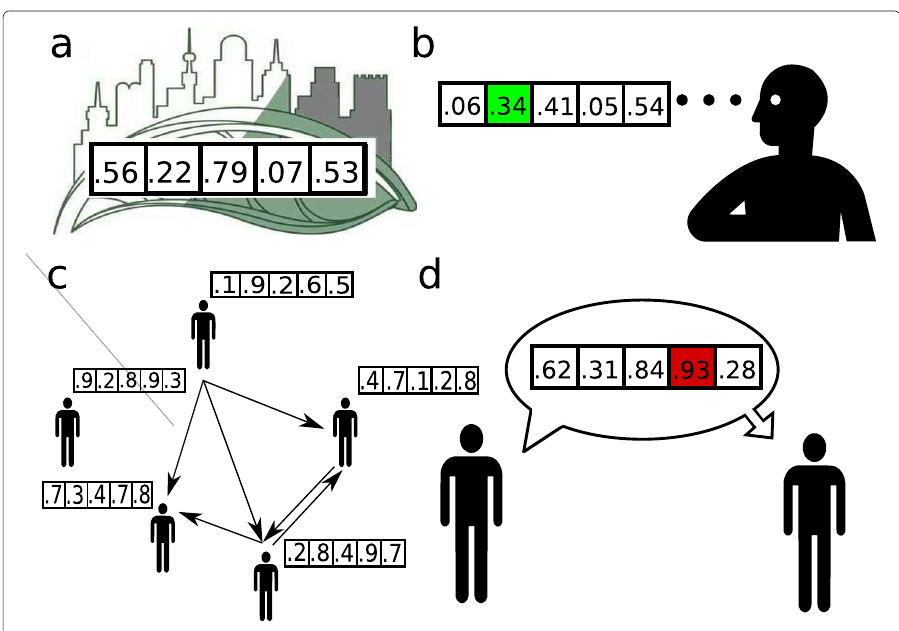
Fig. 1 The basic properties of the model a An “external reality” (or “environment”), which can be observed by the agents, is given. This environment is represented by K randomly generated numbers taken from the [0,1] interval with uniform distribution. In the example of this figure K = 5. b Each agent-member of the group-maintains a K-long “belief vector” reflecting their information about the “external reality”. Agents are able to observe only a fraction H of the environment (marked green). In this example H = 0.2, that is, the given agent is able to observe 1 element of the environment vector. c and d Agents can also communicate, during which a “source” individual shares the data of a randomly selected element of their belief vector (marked red) with the “target” individual. As a results, the corresponding element of the target individual’s belief vector gets closer to that of the agent sending the data. That is, their corresponding beliefs get closer to each other. This type of communication defines a one-directional information transfer